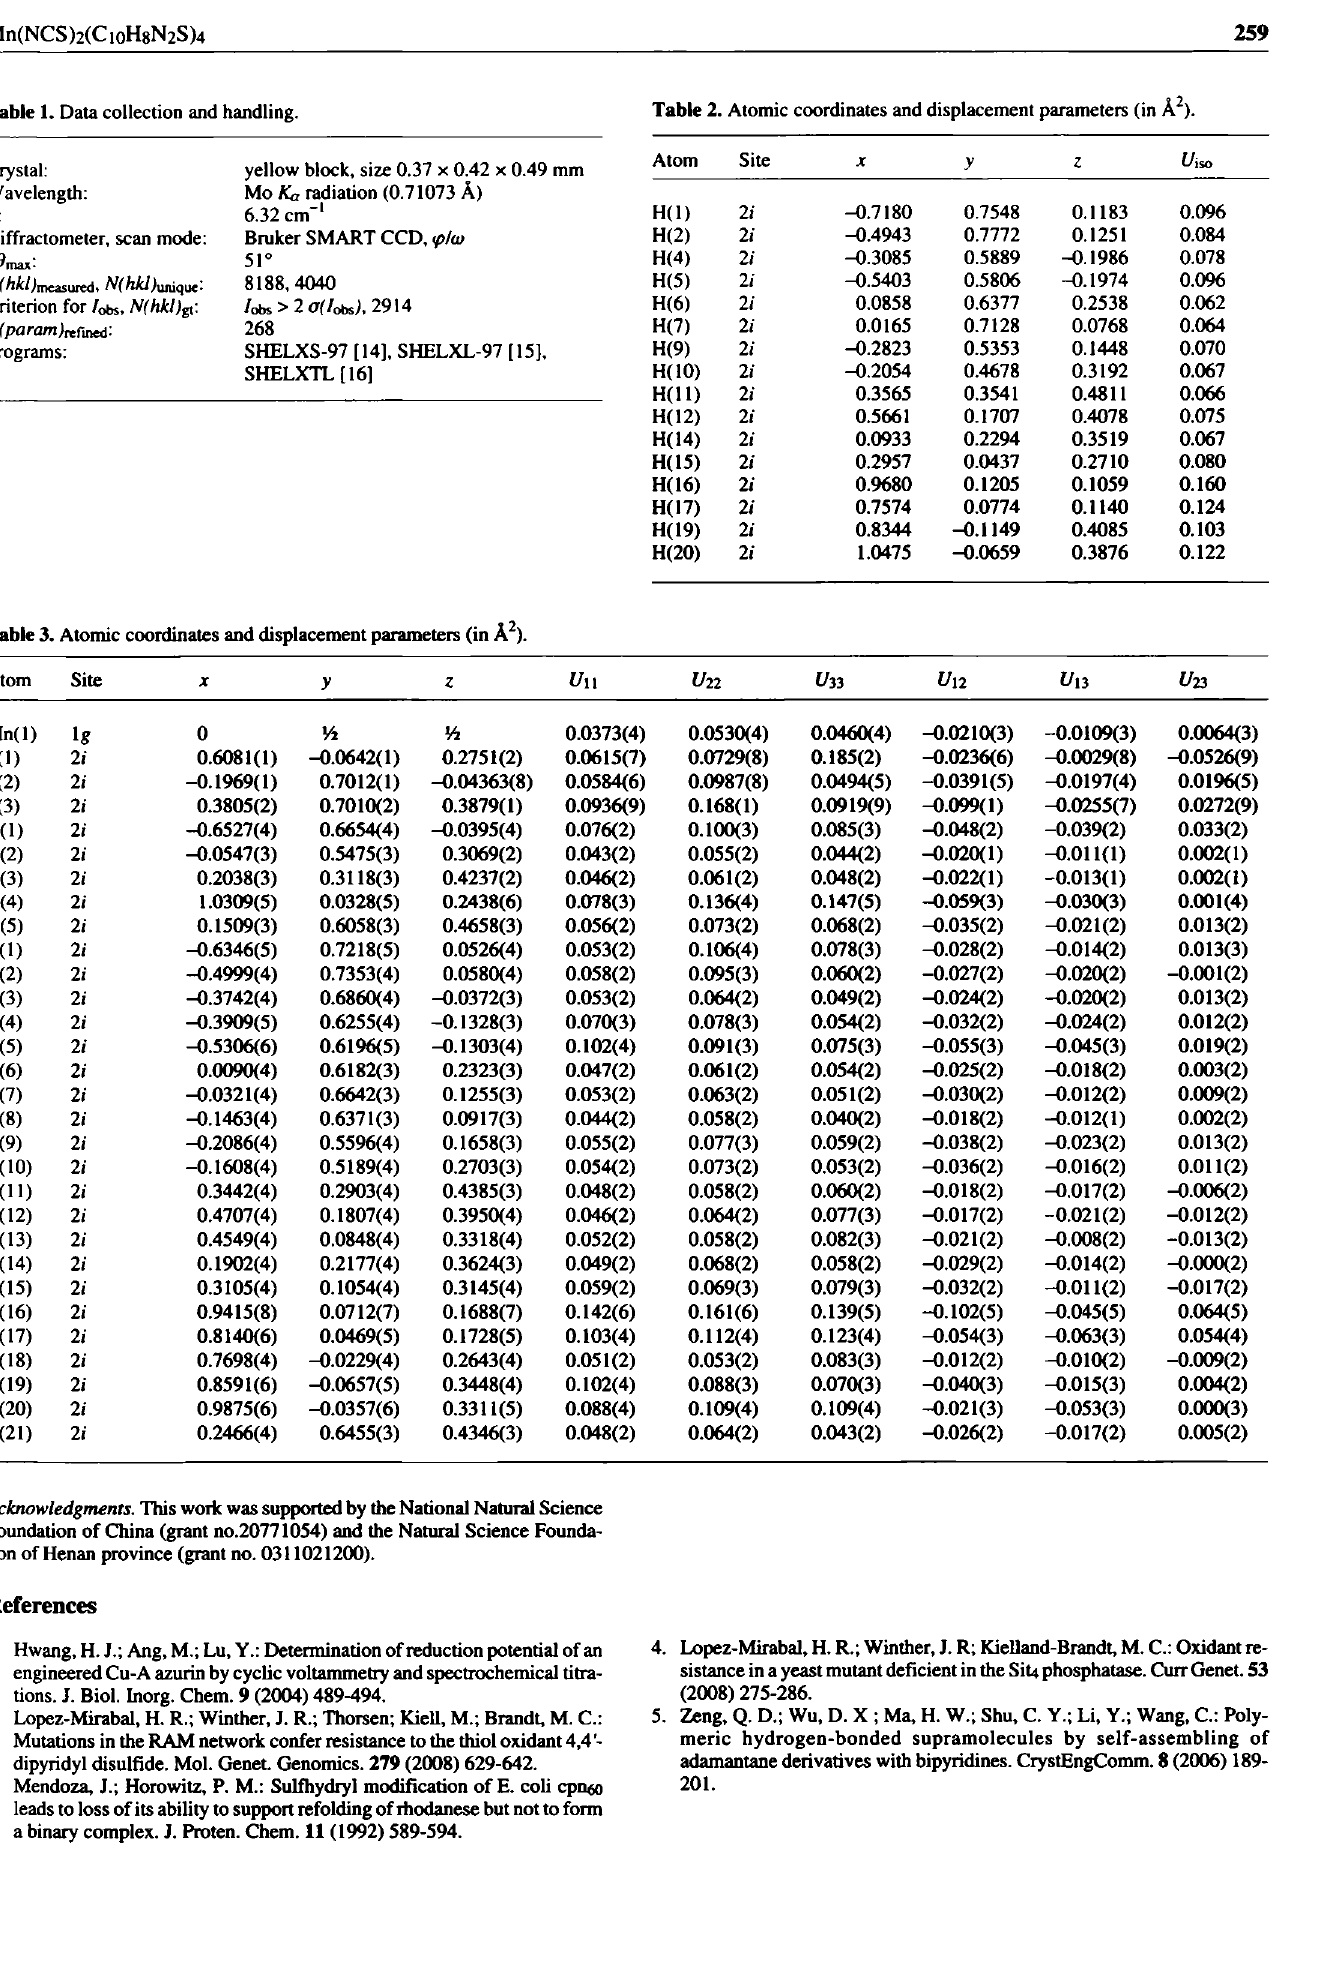
Table 3. Atomic coordinates and displacement parameters (in À 2